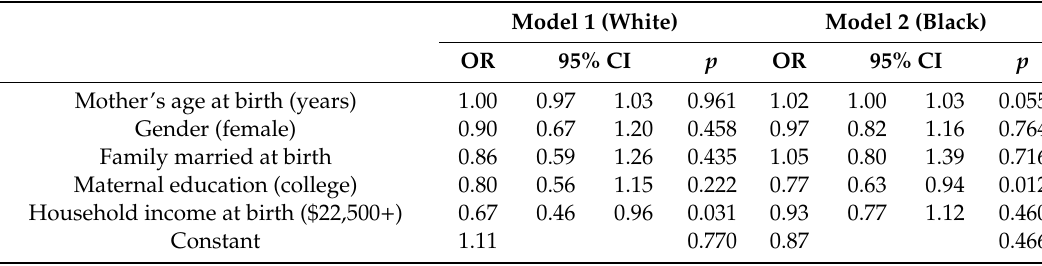
Table 3. Logistic regression models with gang presence in the neighborhood at age 15 as the outcome across races. Model 1 (White) Model 2 (Black) OR 95% CI p OR 95% CI p Mother’s age at birth (years) 1.00 0.97 1.03 0.961 1.02 1.00 1.03 0.055 Gender (female) 0.90 0.67 1.20 0.458 0.97 0.82 1.16 0.764 Family married at birth 0.86 0.59 1.26 0.435 1.05 0.80 1.39 0.716 Maternal education (college) 0.80 0.56 1.15 0.222 0.77 0.63 0.94 0.012 Household income at birth ($22,500 + ) 0.67 0.46 0.96 0.031 0.93 0.77 1.12 0.460 Constant 1.11 0.770 0.87